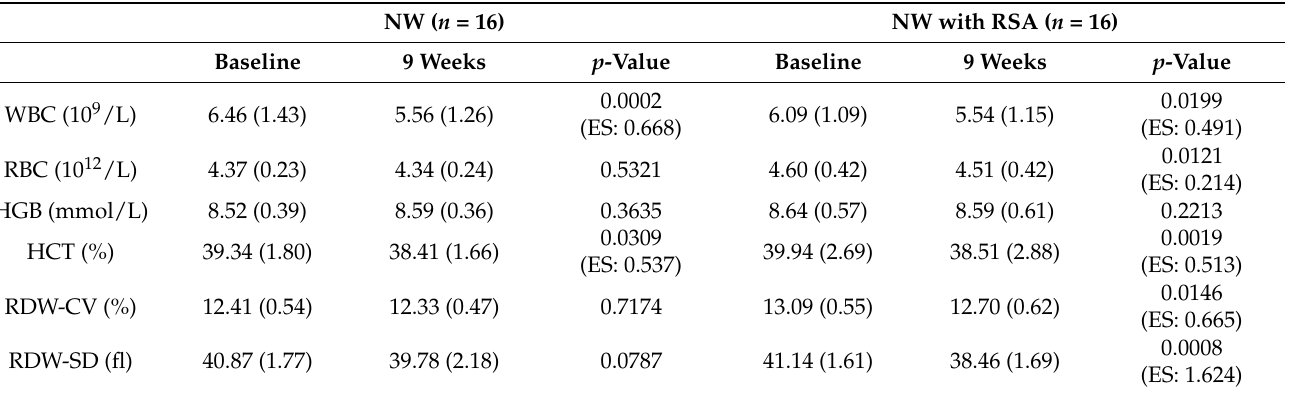
Table 3. Basic characteristics of haematological parameters of women subjected to an eight-week NW and NW with RSA training